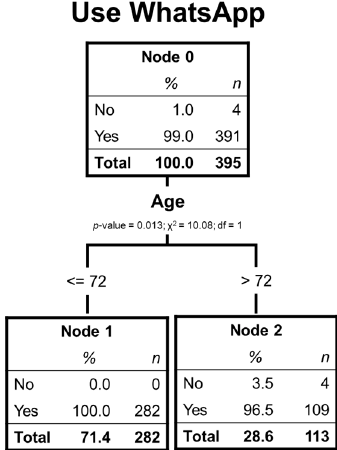
Figure 5. Decision tree of elderly WhatsApp users.